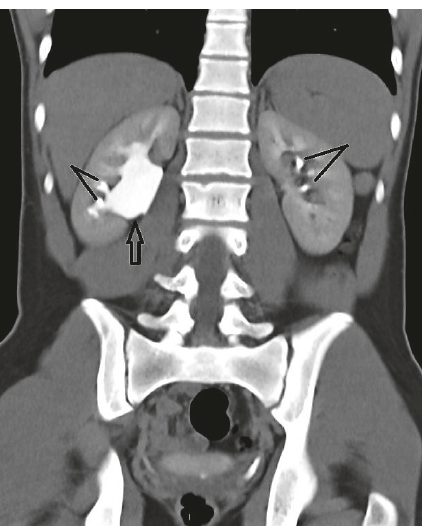
Figure 1: CT-scan of the abdomen and pelvis demonstrating moderately dilated right renal pelvis of 19mm (headed arrow) and bilateral renal stones (dashes).